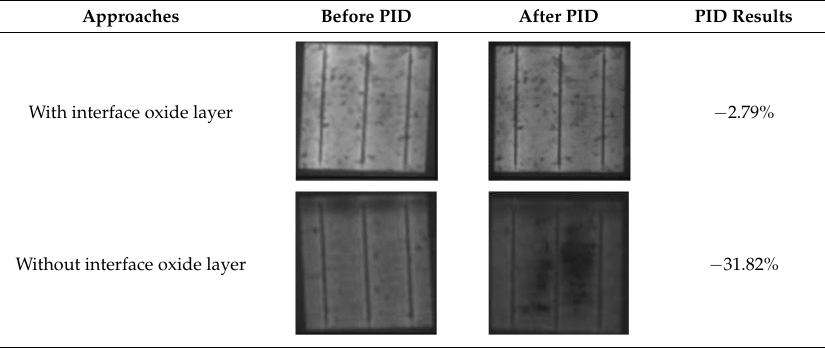
Table 3. The PID testing results and EL images for the solar cells with or without an interface oxide layer between the ARC and Si substrate on indirect PECVD.